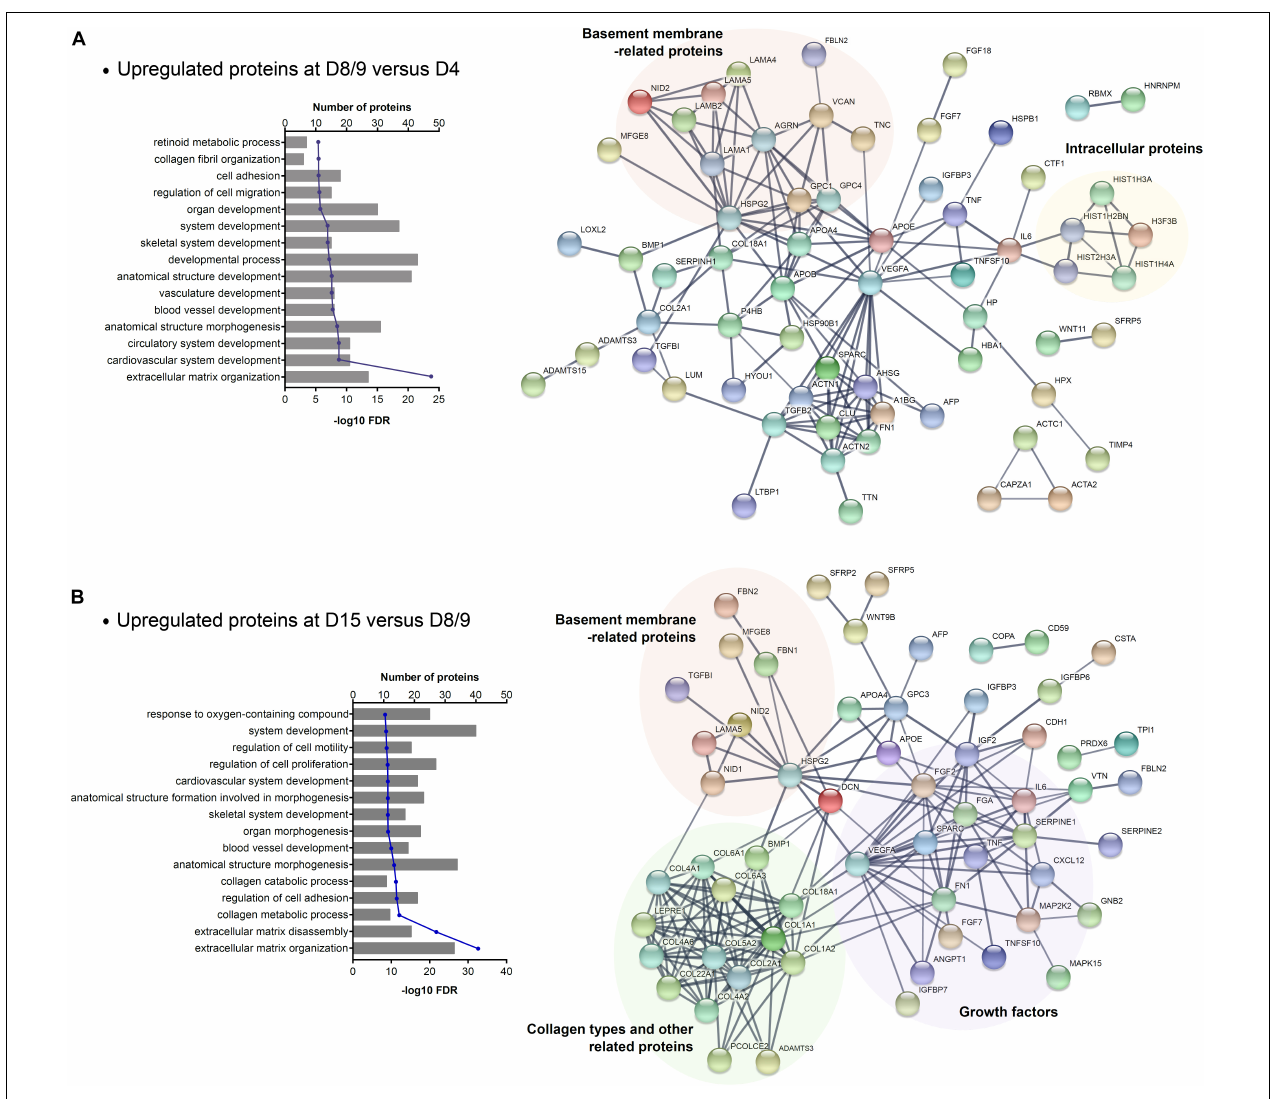
FIGURE 4 | GO enrichment analysis of secretome (CM + ECM) proteins upregulated during late stages of cardiomyogenic differentiation. (A) Biological process related to proteins upregulated at days 8–9 (CMd8 and ECMd9) compared to the previous time point and the STRING network of these protein–protein interactions. (B) Biological process related to proteins upregulated at day 15 (CMd15 and ECMd15) compared to the previous time point and the STRING network of these protein–protein interactions.